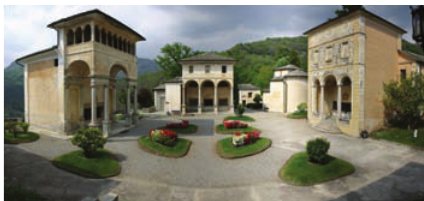
Figure 2: The Sacred Mountain of Varallo. The Square of Tribunals.